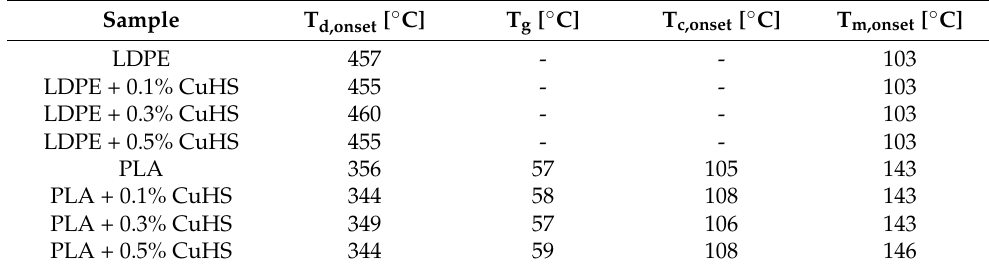
Table 1. Results obtained from thermal analysis using the TGA and DSC of neat and composite films.